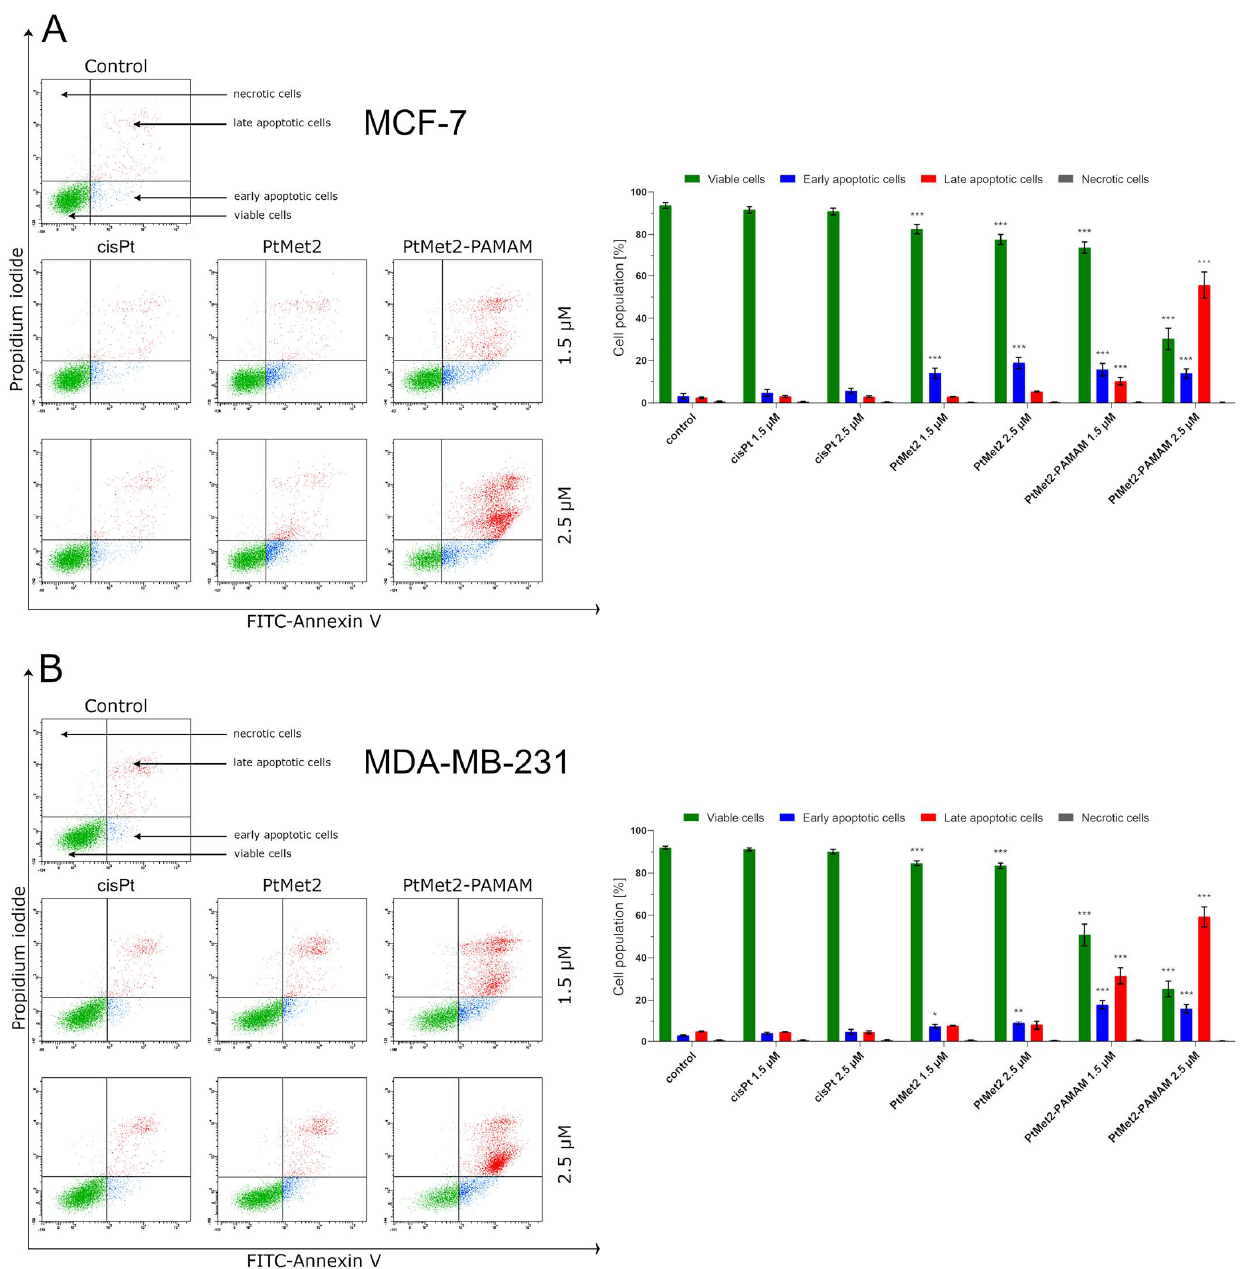
Figure 5. Flow cytometry analysis of MCF-7 ( A ) and MDA-MB-231 ( B ) breast cancer cells after 24 h incubation with PtMet2, PtMet2–PAMAM, and cisplatin (1.5 μM and 2.5 μM) and subsequent staining with Annexin V and propidium iodide. Mean percentage values from three independent experiments ( n = 3) done in duplicate are presented. * p < 0.05 vs. control group, ** p < 0.01 vs. control group, *** p < 0.001 vs. control group.